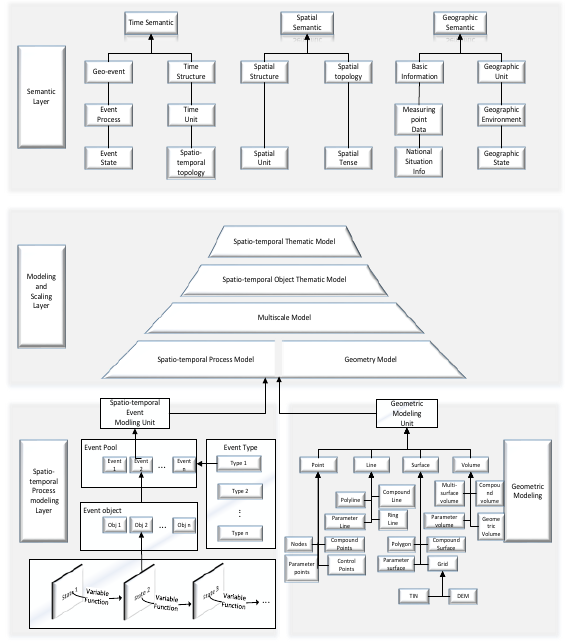
Figure 2. Geographic spatiotemporal concept model